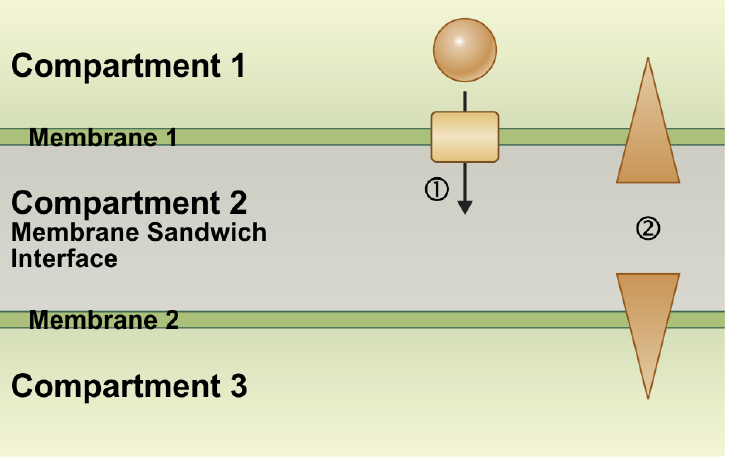
Figure 1. The basic principle of coupling transport processes at membrane sandwiches. Two adjacent membranes separate three compartments. In one possible scenario, compartments 1 and 3 are the cytosol of two neighboring cells, the membranes are the plasma membranes, and compartment 2 is the apoplast. In another scenario, compartment 1 is the apoplast, compartment 2 the cytosol, and compartment 3 is an intracellular organelle, such as the vacuole. In this case, membrane 1 is the plasma membrane and membrane 2 is the organelle membrane (e.g., the tonoplast). (1) The transport of a molecule across membrane 1 changes the concentrations of that substance in compartments 1 and 2. (2) The altered concentrations, in turn, change the transmembrane concentration gradients not only at membrane 1 but also at membrane 2, thereby affecting the transport processes even across that membrane.